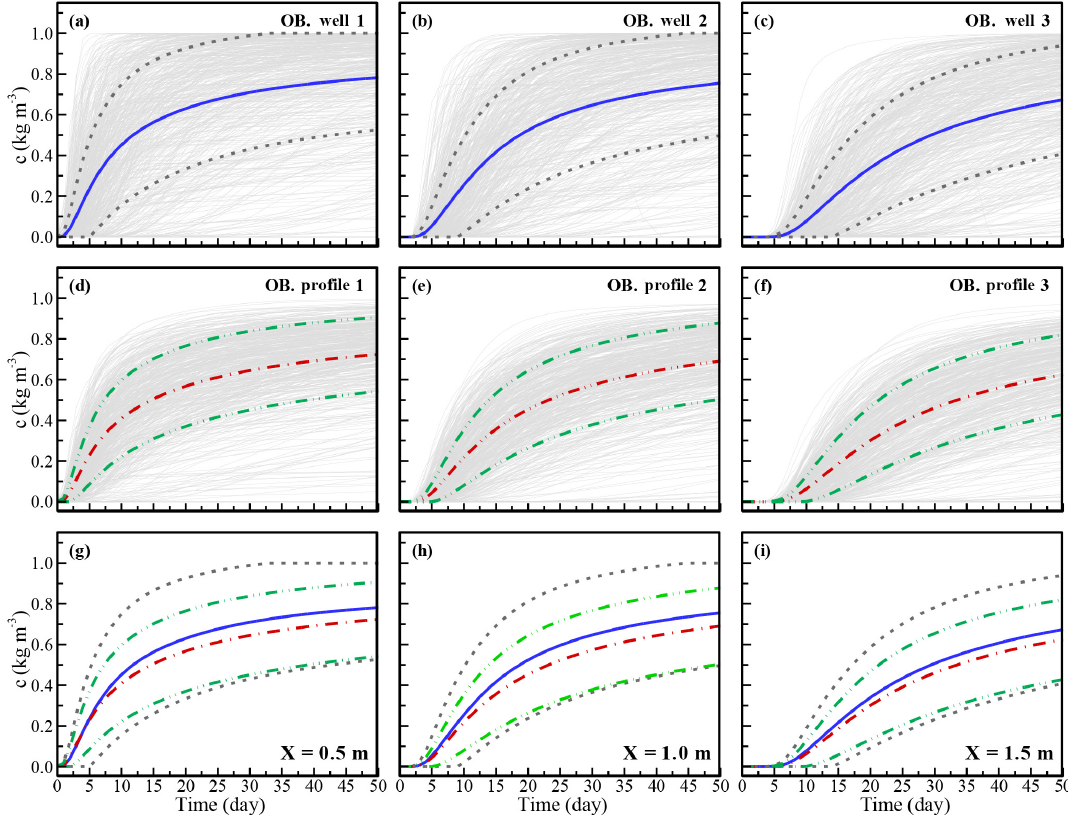
Figure 11. Mean concentration BTCs (solid lines) and associated SD intervals (dashed lines) at the sampling wells for (a) x = 0 . 5, (b) x = 1 . 0, and (c) x = 1 . 5m, and the mean BTCs (dashed and dotted lines) and SD for the sampling profiles at (d) x = 0 . 5, (e) x = 1 . 0, and (f) x = 1 . 5m. The BTC statistics, which were based on different averaging strategies, are presented at (g) x = 0 . 5, (h) x = 1 . 0, and (i) x = 1 . 5m, where the solid lines in (g) , (h) , and (i) indicate the average BTCs along the wells, and the dashed and dotted lines represent the average BTCs along the